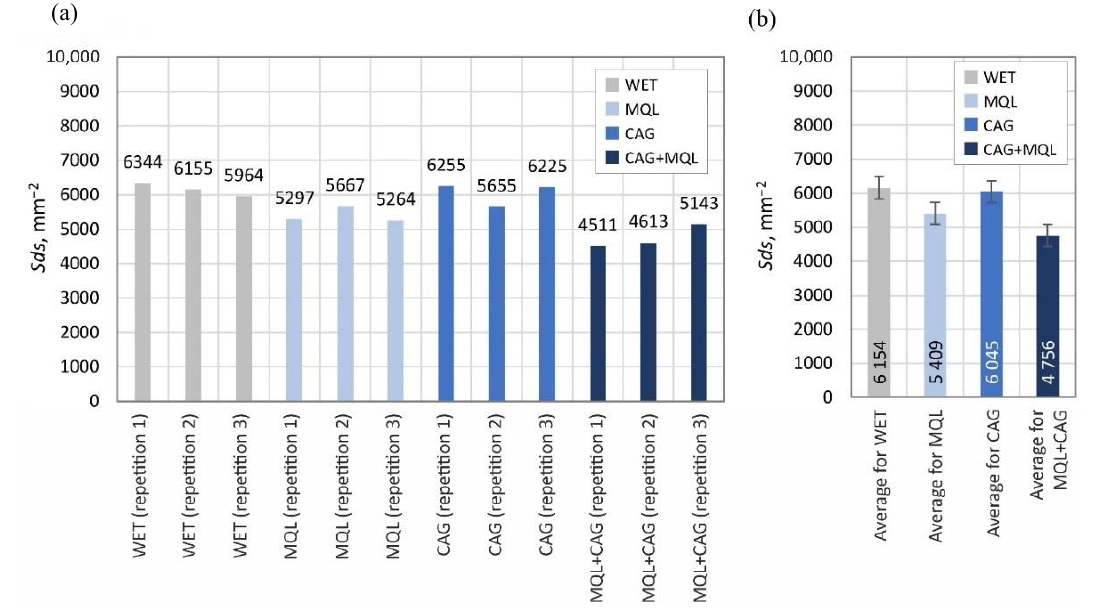
Figure 10. Chart of changes in the density of summits of the surface Sds : ( a ) results for the twelve blades selected for the surface texture measurements; ( b ) mean values of the parameters divided by cooling and lubrication methods of the grinding zone used during the shaping of the blades (error bars represent the standard error equal to the standard deviation σ divided by the square root of the total number of samples).